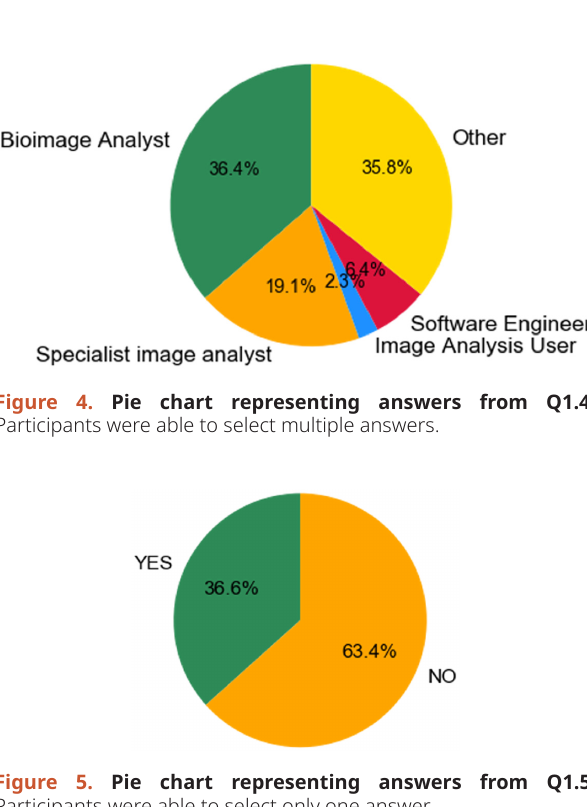
Figure 6. Pie chart summarising answers from Q2.3. What best describes your position? Participants were able to select only one answer.